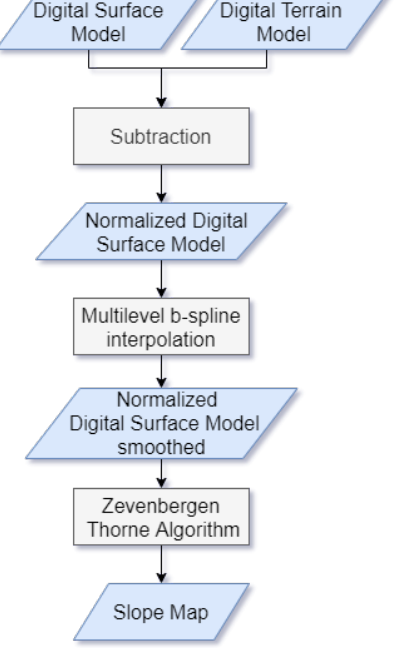
Figure 7. Flowchart for preprocessing LiDAR